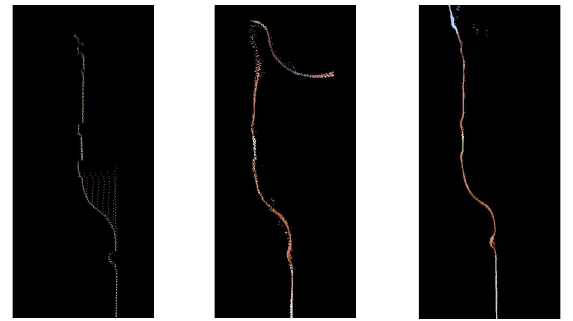
Figure 25. Profiles of the same architectural detail obtained from three different point clouds. Left one comes from the TLS, the middle one from the unique model, and the right from the M3